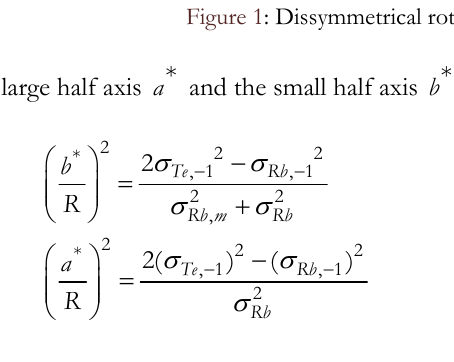
Figure 1: Dissymmetrical rotating bending (Eq. 5a) and line Iso-energy